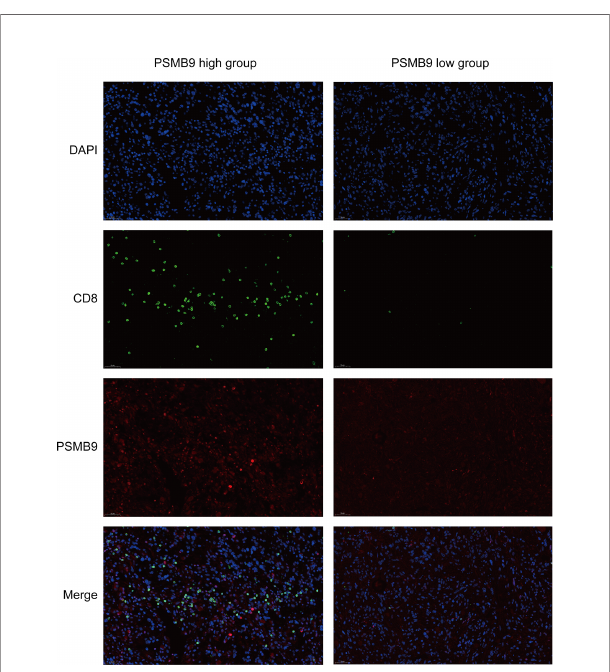
FIGURE 8 | Fluorescent Immunohistochemistry of LGG tumor tissue. DAPI is used to display the localization of nucleus, green represents CD8 protein, red represents PSMB9 protein, and Merge is the overlapping of three